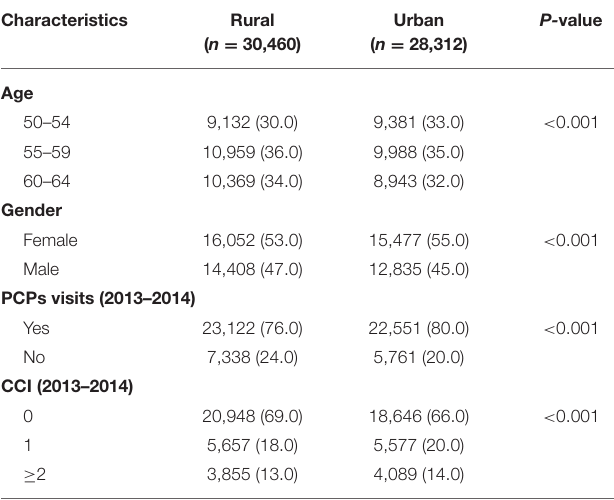
TABLE 1 | Characteristics of BCBSNE members eligible for colorectal cancer screening by rural/urban residence ( N = 58,774).